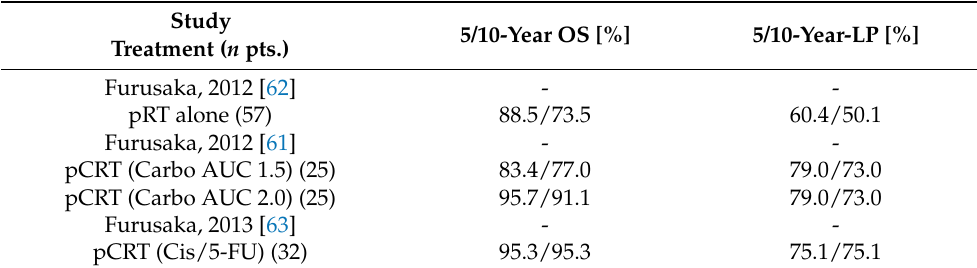
Table 7. Oncological outcome after pRT and pCRT in T2 glottic cancer patients in three series of